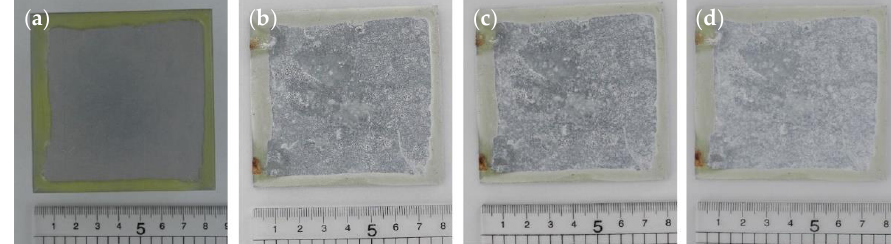
Figure 11. Humidity samples of uncoated HDG at ( a ) 0 h ( b ) 250 h ( c ) 500 h and ( d ) 1000 h.